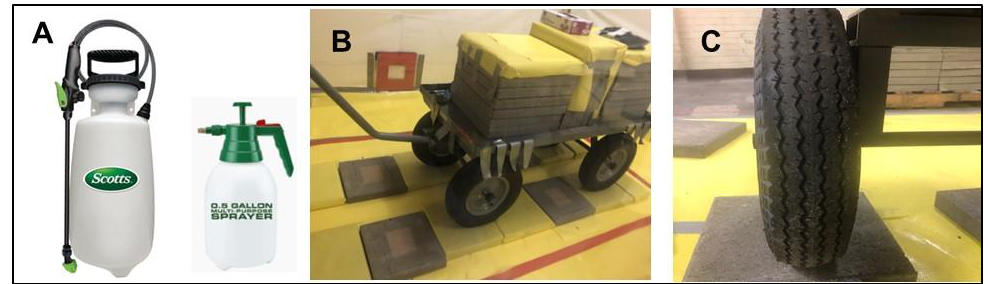
Figure 6. Sprayers Used in Study ( A ), Wagon Used to Simulate Applicable Vehicle ( B ), and Simulated Vehicle Tire ( C ).